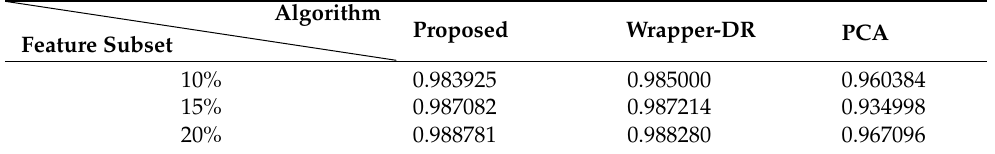
Table 3. Result of detection rate: table. Feature